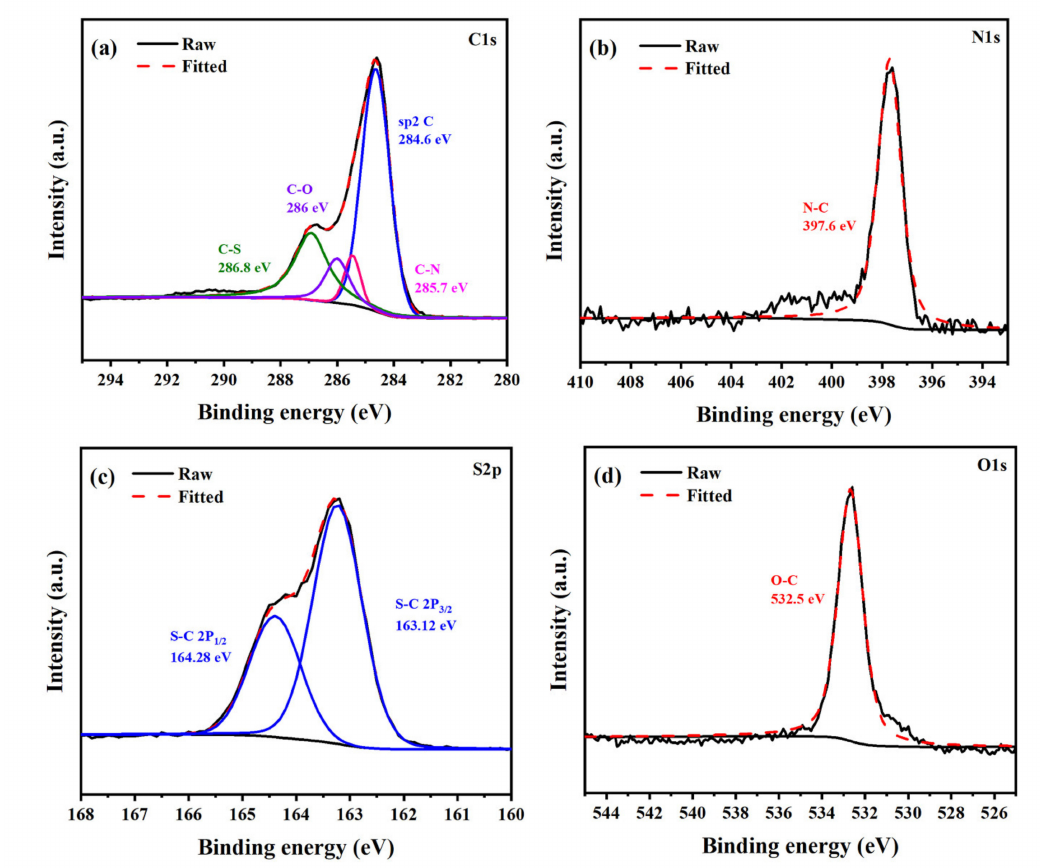
Figure 5. The High-resolution XPS spectra of PTT-O@C ( a ) C 1s, ( b ) N 1s, ( c ) S 2p and ( d ) O